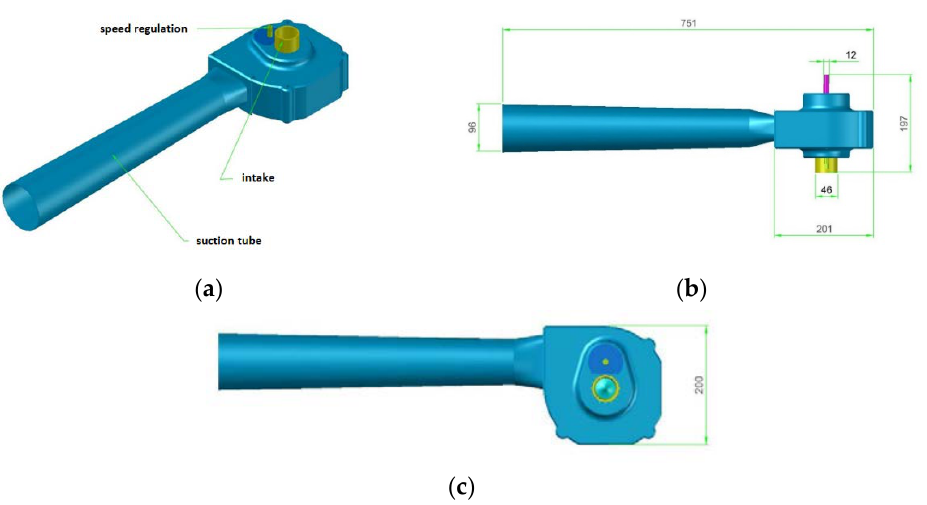
Figure 2. Turbine prototype: ( a ) description; ( b , c ) dimensions. Units: mm.